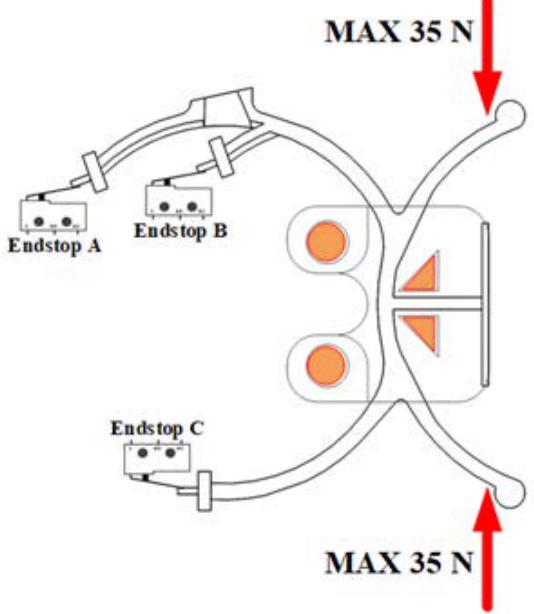
Figure 9. Principle schematics of testing.